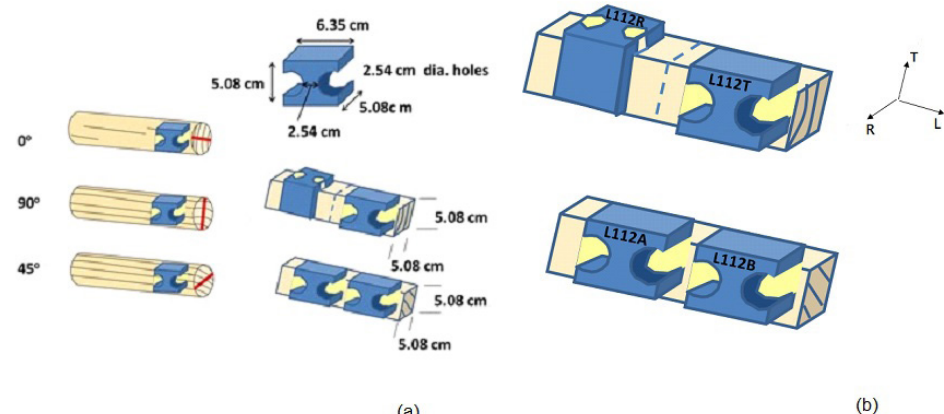
Figure 2. (a) Cut out pattern for 0 ° , 90° and 45°-directions; (b) labeling convention for tension perpendicular to grain